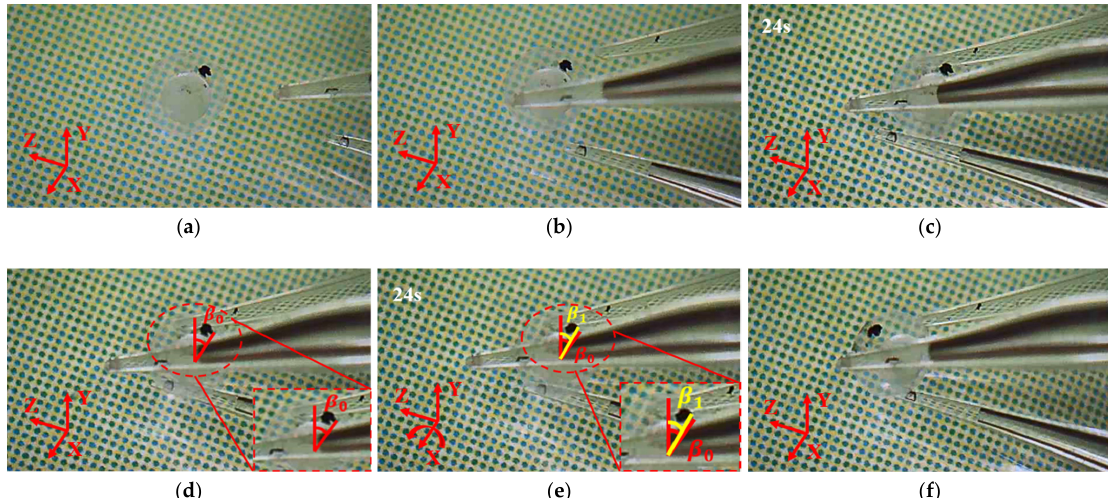
Figure 21. Manipulation of a zebrafish embryo: ( a ) Initial state; ( b ) approaching the micro embryo; ( c ) the embryo is gripped; ( d ) the embryo is moved to a distance; ( e ) the embryo is rotated about axis X; ( f ) the embryo is released.